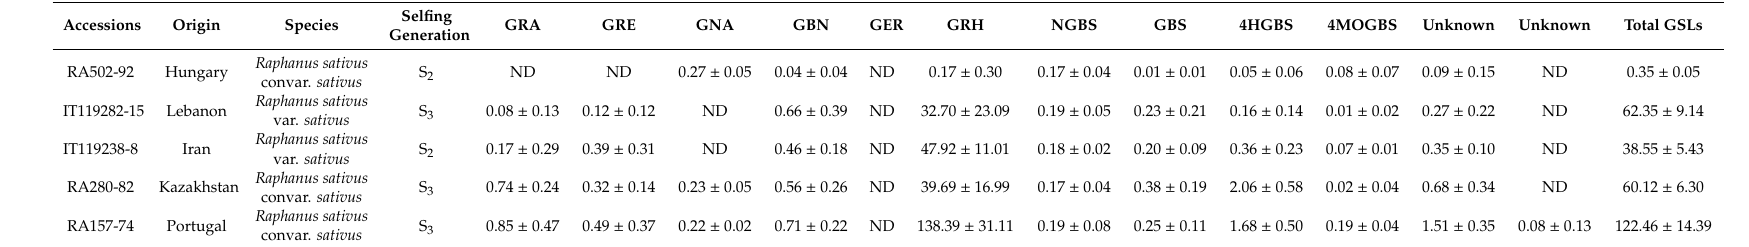
Table 2. GSL content in the roots of the five selected